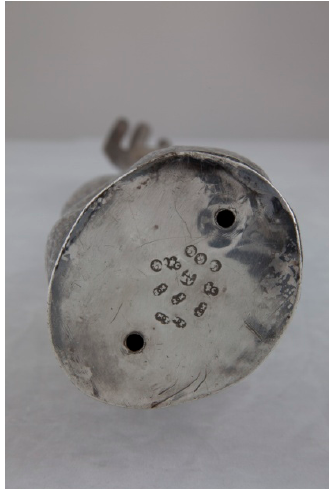
Figure 8. Bottom of an arm-shaped reliquary, 18th century, Cathedral of Saint Tryphon, Kotor, photo by Stevan Kordi ć .